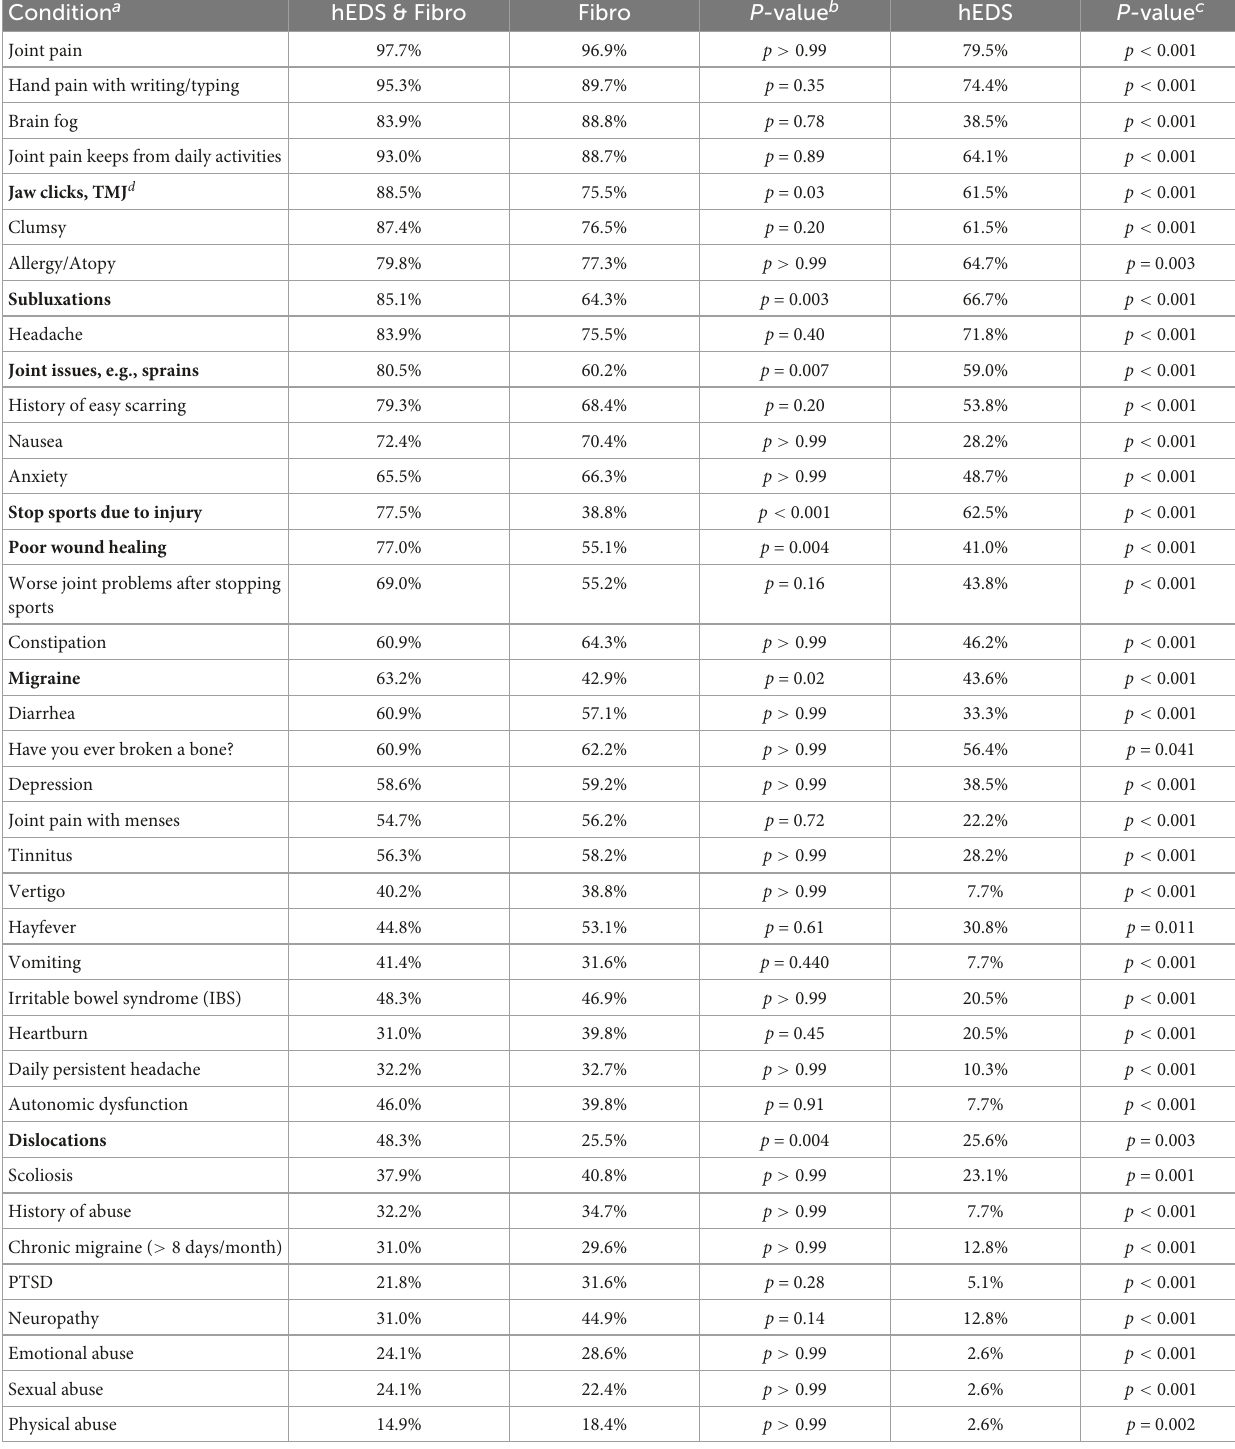
TABLE 10 Comparison of hEDS&Fibro ( n = 87) to Fibro ( n = 98) or hEDS ( n = 39) in men and women. Condition